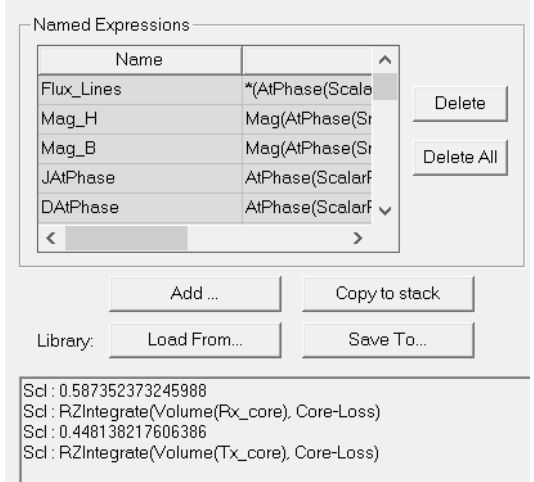
Figure 9. The core losses of the transmitter core and the receiver core at a given operating point. The core losses of the transmitter core and the receiver core obtained by theoretical model calculation and FEA simulation are compared under different winding currents, as shown in Figure 10, where there is no phase-shift between the transmitter winding current and the receiver winding current. shifts, as shown in Figure 11, where the transmitter winding current I p = 12 A.